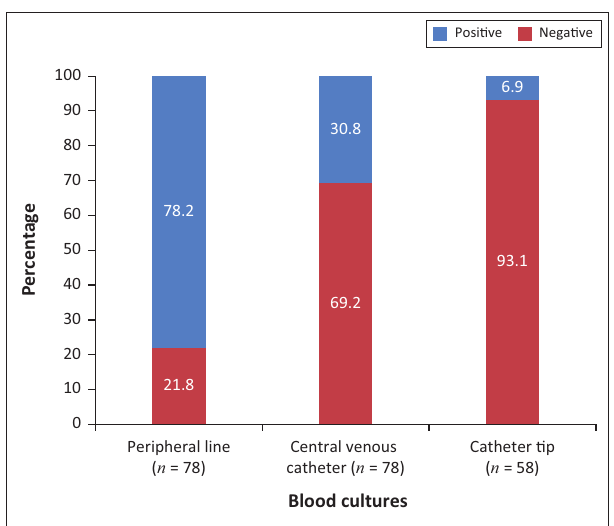
FIGURE 2: Percentage of positive blood cultures from different sites in 78 cases. Fifty-eight patients had the catheter removed.